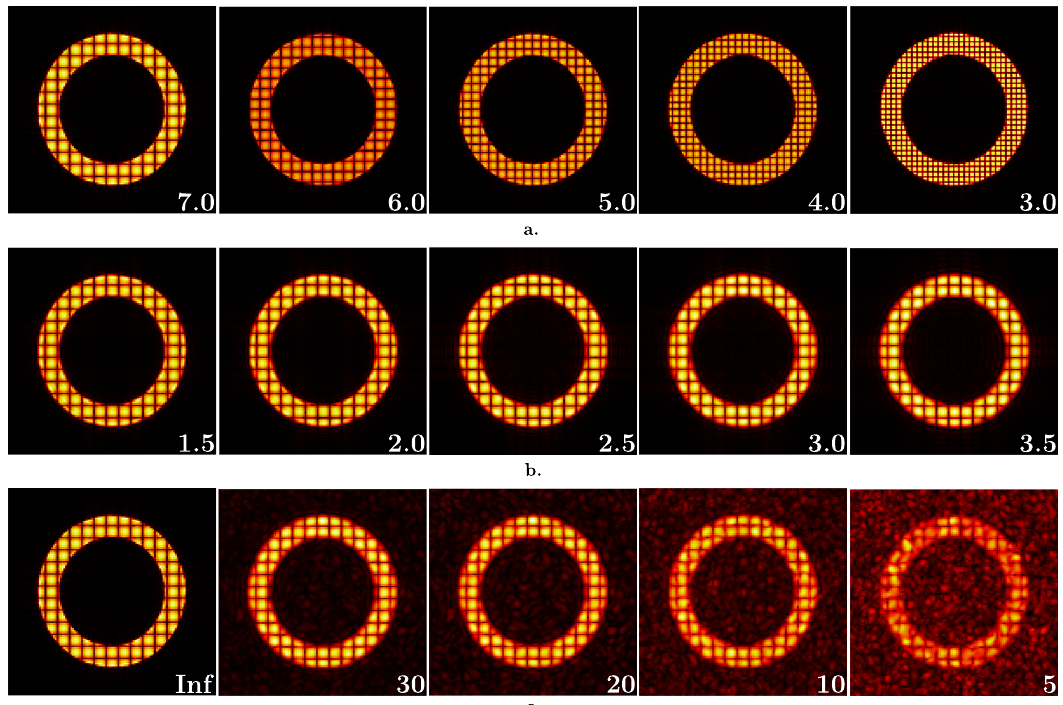
Fig 2. Isotropic synthetic images to analyze the effect of image properties. Images with varying tag distances (in mm) (a), pixel sizes (in mm) (b), and SNRs (c) (values are written at the bottom right corner for each case). Images shown in (a) are noiseless and have 1 mm pixel size. Images in (b) are noiseless and have 7 mm tag distance. For the ones in (c), pixel size and tag distance are 3.5 mm and 7 mm, respectively. Images represent the configuration at end-diastolic time